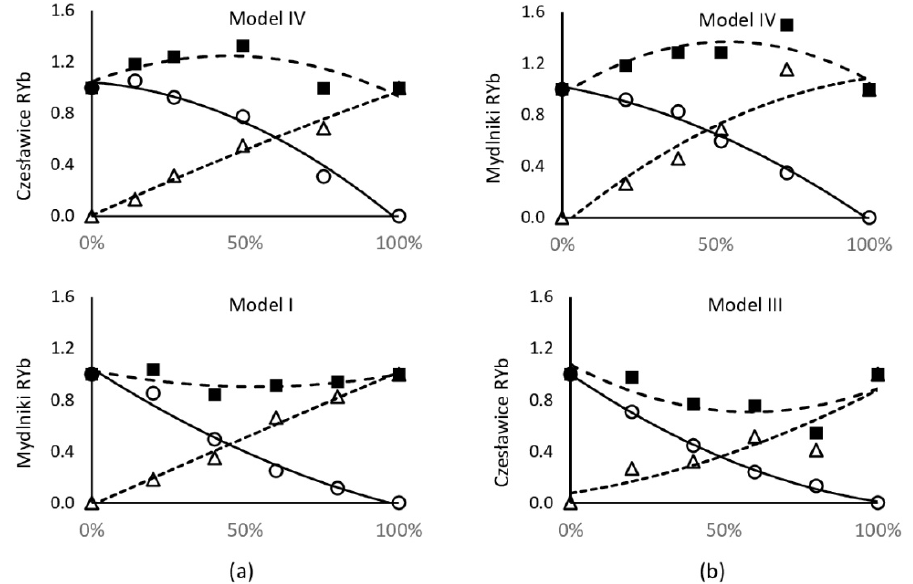
Figure 12. The replacement competition model for the relative biomass yield (RYb) of winter wheat and cornflower (B) in the 2019–2020 season, classified according to the t -test and p -values < 0.05. ( a ) competition between WW and B resistant (R) and ( b ) competition between WW and herbicide-susceptible cornflower (S). Legend: o—WW; ∆ —R ( a ) or S ( b ), □ —WW + R ( a ) or WW + S ( b ).